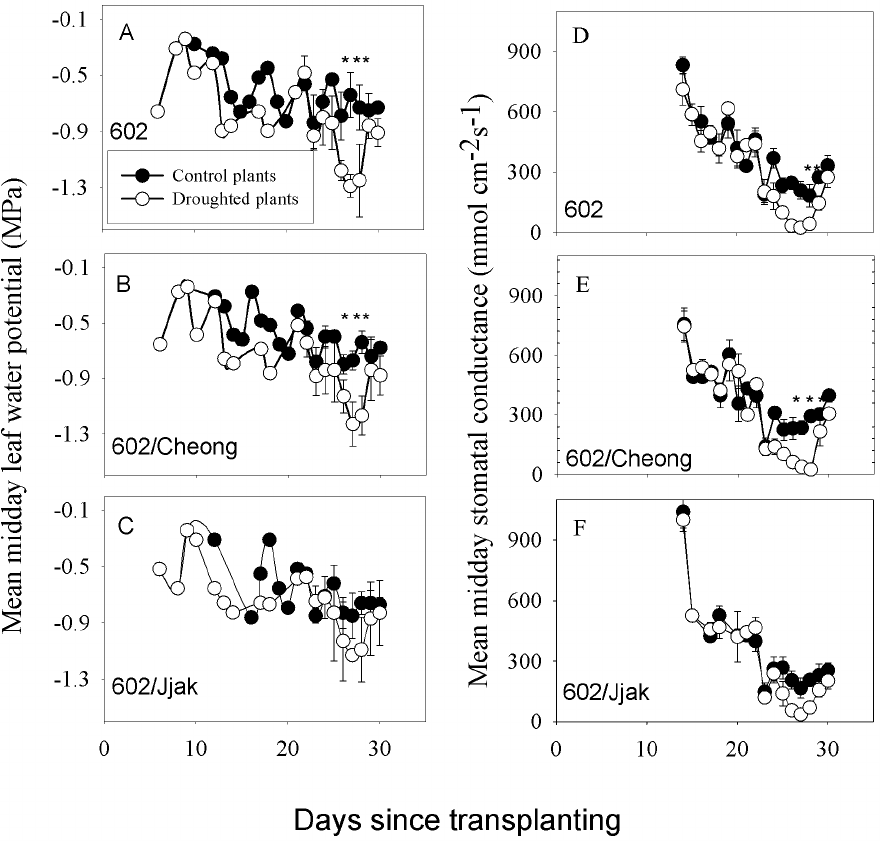
Fig. 4. Mean midday water potential (A, B, C) and midday stomatal conductance (D, E, F) for three different lines of tomato grown with daily watering (control) or daily watering until water was withheld between day 20 and day 28 (mild-drought treatment). 602 5 ‘BHN 602’; 602/Cheong 5 refers to line ‘BHN 602’ scion grafted onto ‘Cheong Gang’ rootstock; 602/Jjak refers to line ‘BHN 602’ scion grafted onto ‘Jjak Kkung’ rootstock. Error bars represent two standard errors on each side of the mean. * 5 significant difference between control and mild-drought treated plants within a plant type (Student’s t-test; p ,